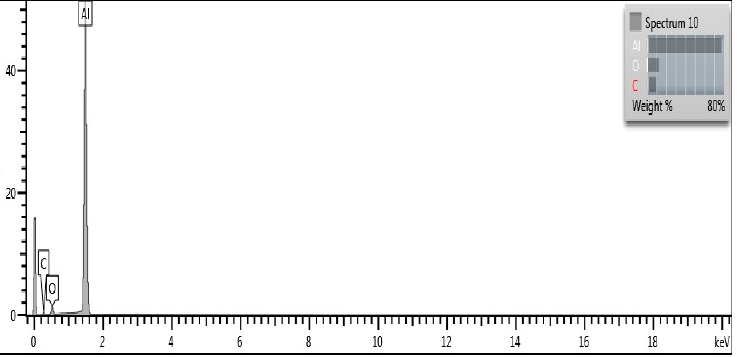
Figure 2. Chemical composition of Al NP.